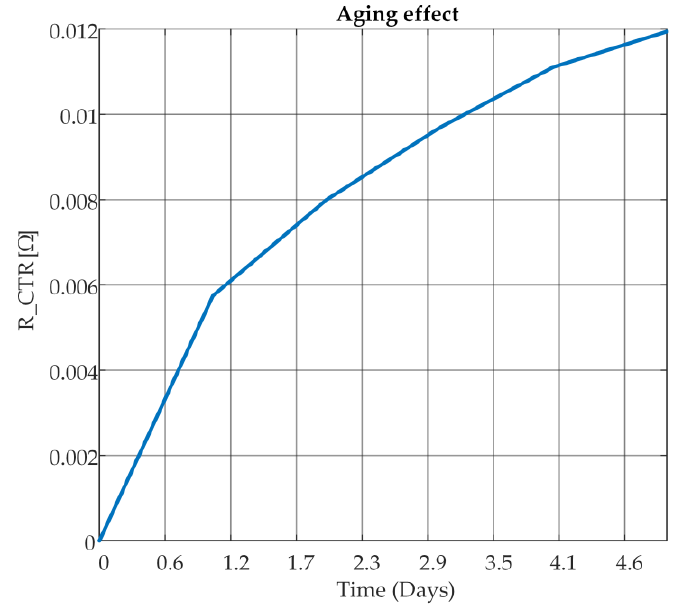
Figure 5. The change in charge transfer resistance for 5 days in an idle condition.